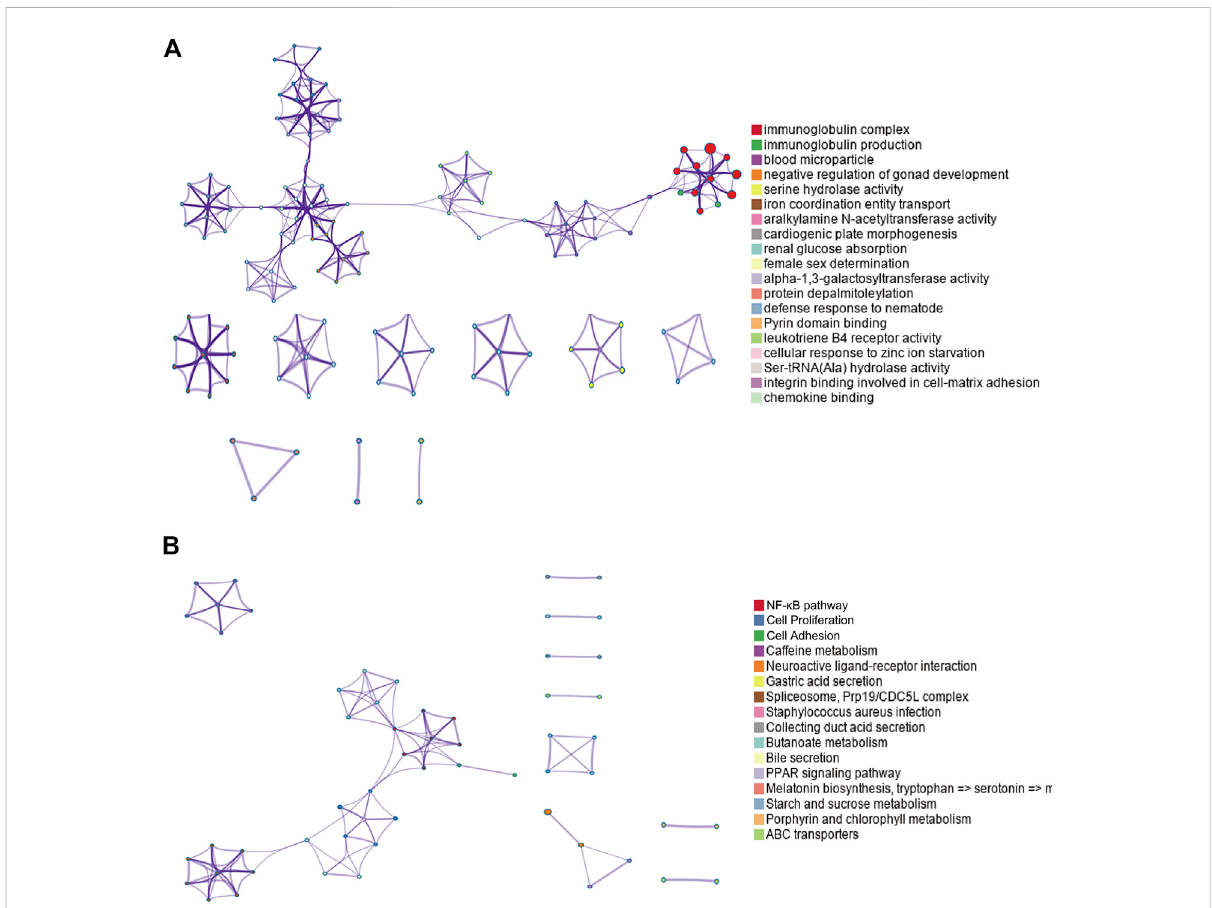
FIGURE 2 GO and KEGG enrichment results for differentially expressed genes. (A) Top GO term enrichment results with the largest number of genes. In the fi gure, the horizontal axis represents the number of enriched genes, and the vertical axis represents the name of each GO term, respectively. (B) EnrichmentresultsoftheKEGGpathwayswiththelargestnumberofgenes.Thehorizontalaxisinthe fi gureindicatesthenumberofgenesenriched, and the vertical axis indicates the name of each KEGG pathway, respectively.